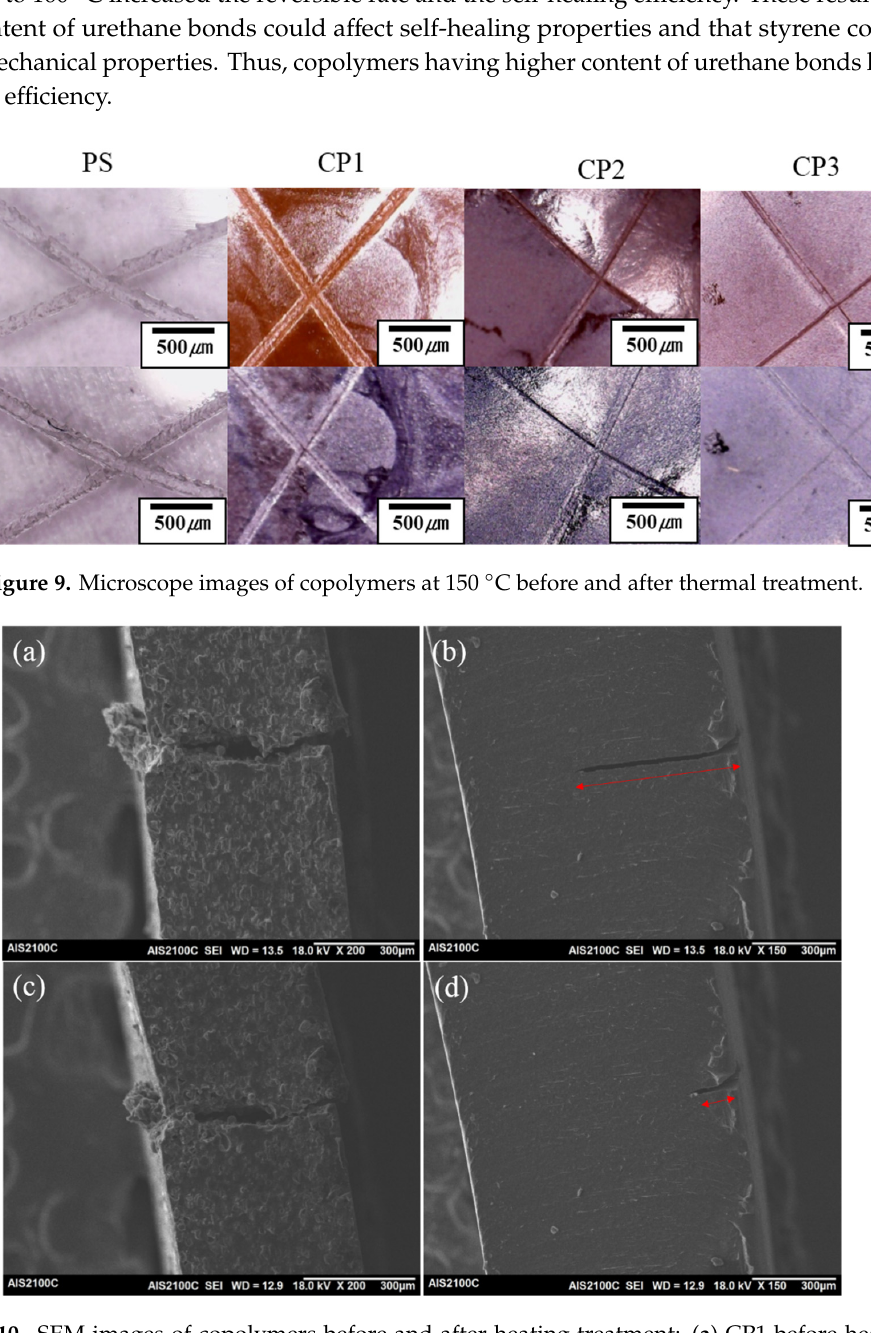
Figure 10. SEM images of copolymers before and after heating treatment: ( a ) CP1 before healing; ( b ) CP3 before heated; ( c ) CP1 after healing at 150 ° C for 12hr; ( d ) CP3 after healing at 150 ° C for 12hr.